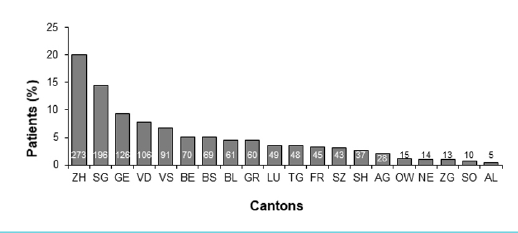
Figure 1: Percentage and number of type 2 diabetic patients en- rolled by canton.ZH = Zürich; SG = St Gallen; GE = Genève; Vaud = VD; VS = Valais; BS = Basel-Stadt; BL = Basel-Landschaft; GR = Graubünden; LU = Luzern; TG = Thurgau; FR = Freiburg; SZ = Schwyz; SH = Schaffhausen; AG = Aargau; OW = Obwalden; NE = Neuchâtel; ZG = Zug; SO = Solothurn; AL = Appenzell